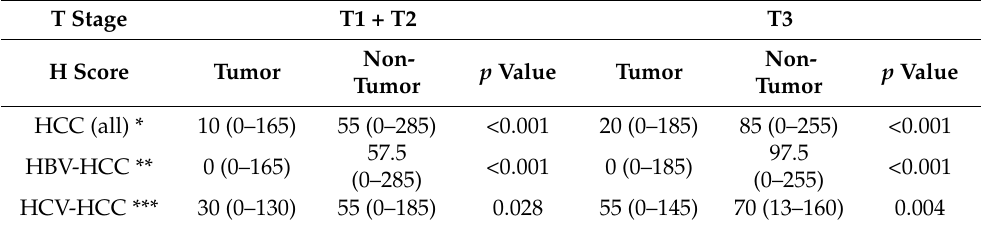
Table 2. TID1 expression (H score) in tumor and non-tumor tissues of paired HCC patients divided by TNM-T